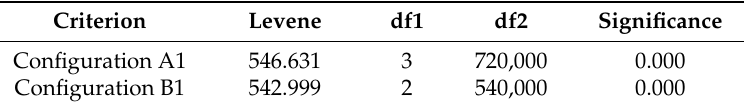
Table 17. Variance homogeneity test result of electric motor output